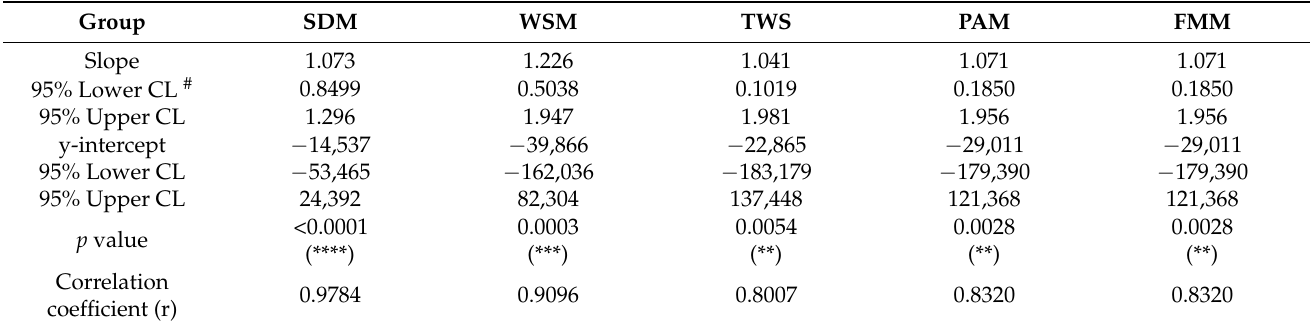
Table 2. Summary of Deming regression of Tetrahymena cell count using five different